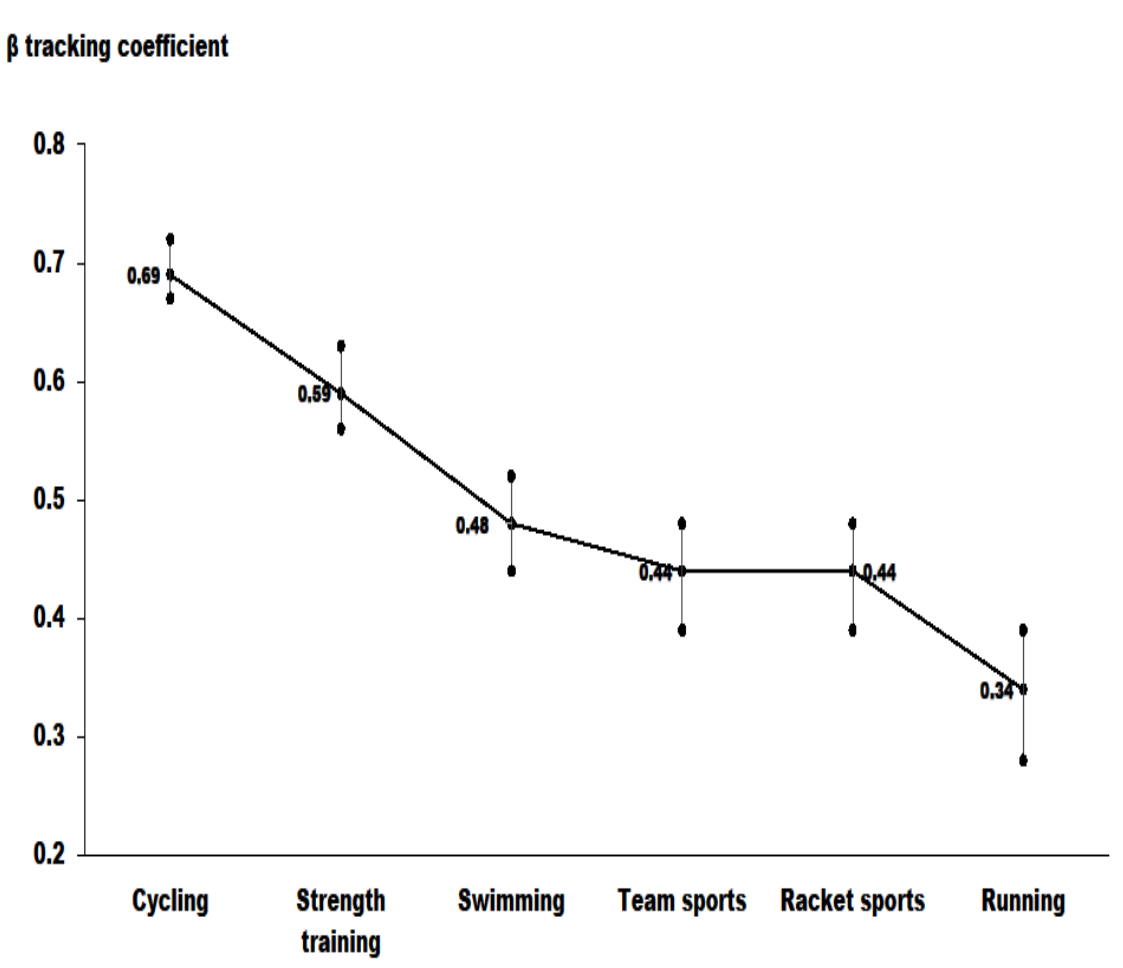
Figure 2. Tracking coefficients ( β ) with 95% CI for each sport-related activity.